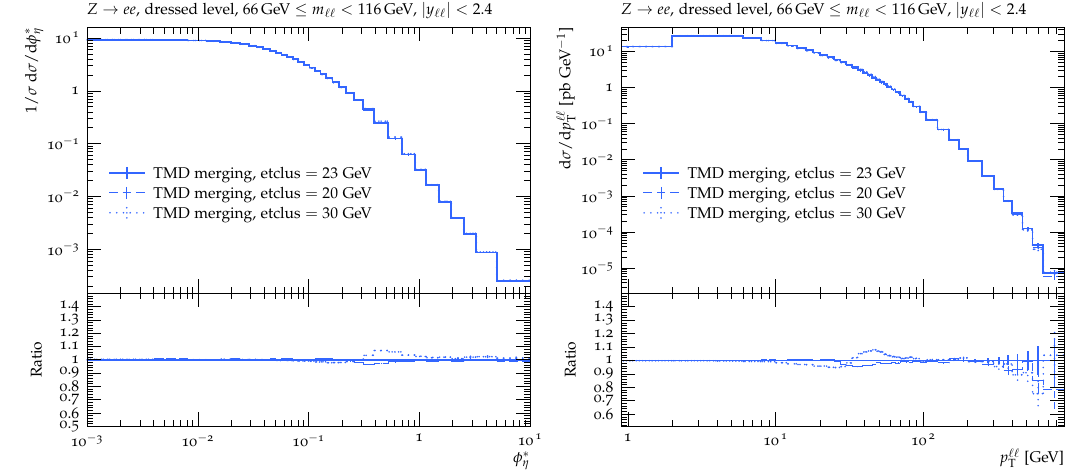
√ s = 8 TeV. The transverse